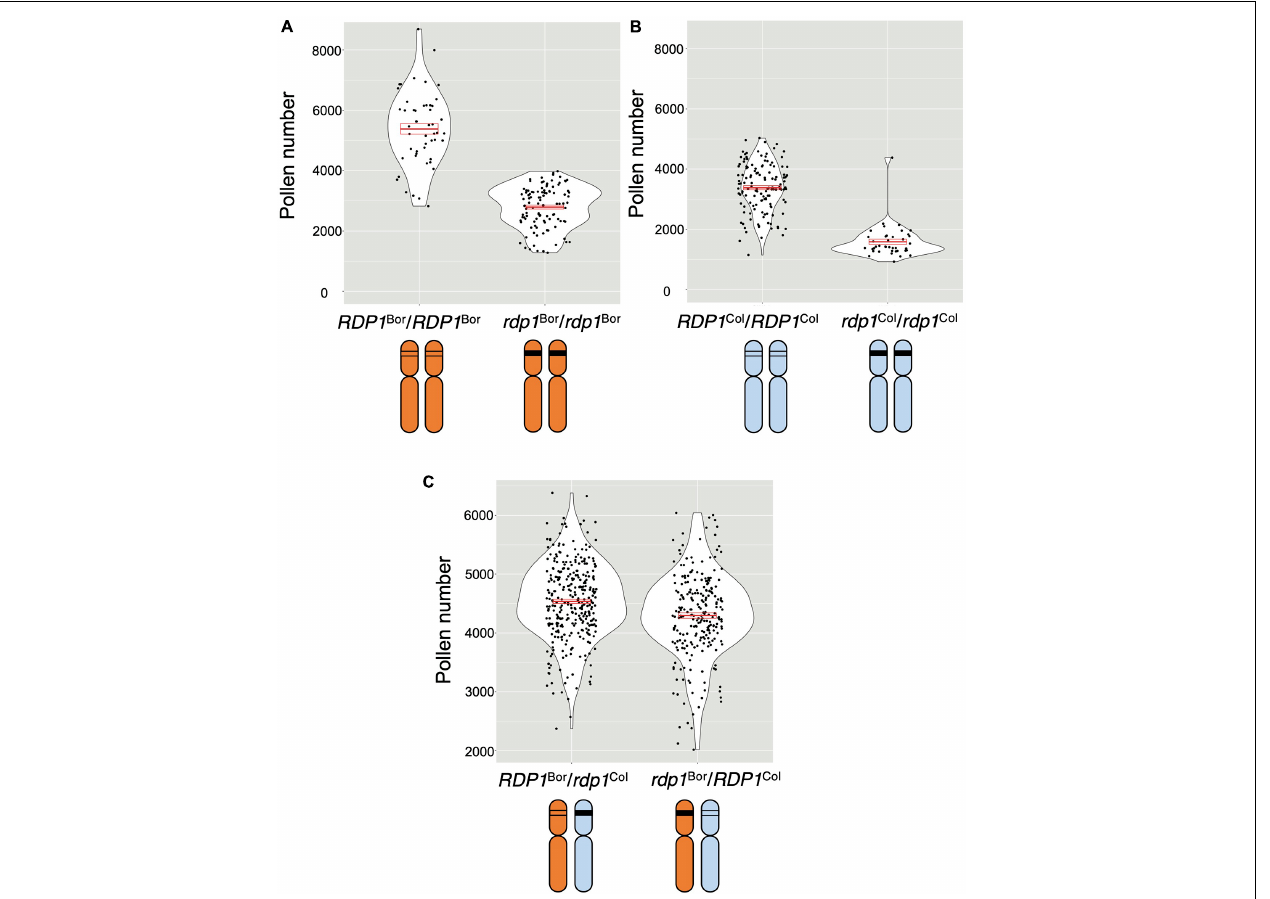
FIGURE 4 | Quantitative complementation test of the RDP1 gene. Pollen number per flower was analyzed. Violin plots with means and standard errors of means indicated by red bold bars and boxes, respectively. (A,B) Pollen-number difference between the wild-type and a homozygote of a frameshift allele generated by the CRISPR/Cas9 technique in the Bor-4 background (A ; n = 50 [ RDP1 Bor /RDP1 Bor ]; n = 106 [ rdp1 Bor /rdp1 Bor ]) and in the Col-0 background ( B ; n = 135 [ RDP1 Col /RDP1 Col ]; n = 40 [ rdp1 Col /rdp1 Col ]). (C) Difference in the effect of two natural alleles, RDP1 Bor and RDP1 Col , on pollen number. The pollen number in the plants with RDP1 Bor was significantly higher than that in the plants with RDP1 Col (nested analysis of variance; P = 1.10 × 10 − 5 ; n = 315 [ RDP1 Bor /rdp1 Col , median = 4,528 pollen grains/flower]; n = 247 [ rdp1 Bor /RDP1 Col , median = 4,302 pollen grains/flower]). The two alleles were compared in the heterozygous state with a frameshift CRISPR/Cas9 allele in an identical genomic background. F 1 plants were obtained from the cross of two heterozygotes, RDP1 Col /rdp1 Col and RDP1 Bor /rdp1 Bor . Results from four genotypes including RDP1 Bor /RDP1 Col and rdp1 Bor /rdp1 Col were shown in Supplementary Figure 3 .